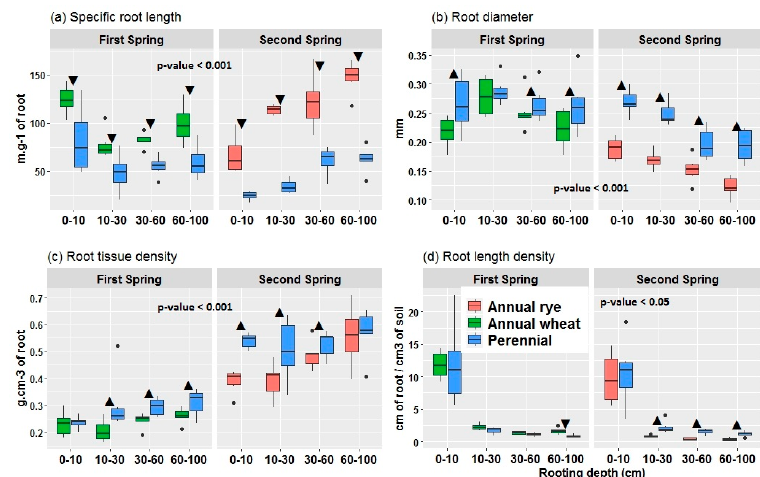
Figure 4. Morphological root traits under annual wheat and intermediate wheatgrass, and between annual rye and the perennial during the first and second growing seasons. p -values refer to the difference between perennial and annual crop treatment. Statistically significant differences (post hoc analyses) are illustrated by ▲ (higher values for the perennial grain) or ▼ (lower value for the perennial grain).